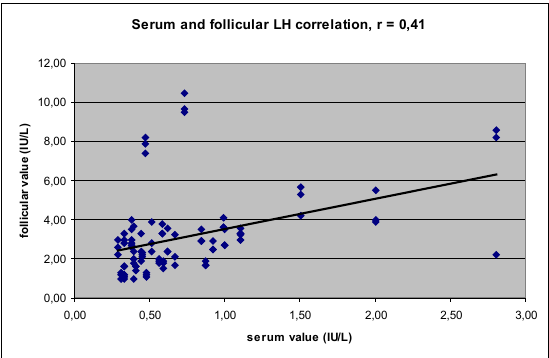
Figure 2. Correlation of follicular LH and estradiol values. Follicular LH i E2 correlation, r = 0,19